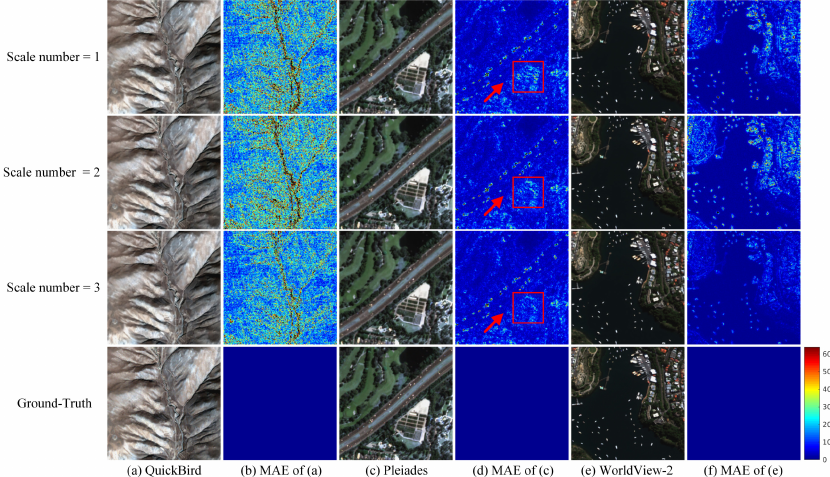
Figure 10. Pansharpening results by using a different number of scales on the three real remote sensing datasets. From top to bottom: fusion results using one, two, and three scales, respectively, and the ground-truth images. From left to right: ( a ) QuickBird dataset, ( b ) MAE map of ( a ), ( c ) Pléiades dataset, ( d ) MAE map of ( c ), ( e ) WorldView-2 dataset, and ( f ) MAE map of ( e